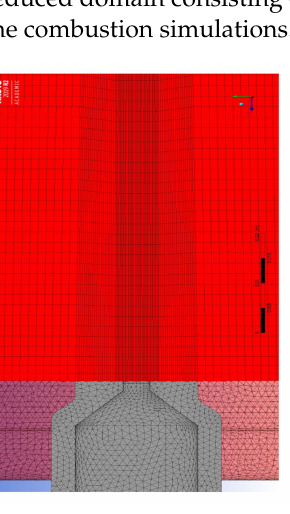
Figure 6. View of the chosen